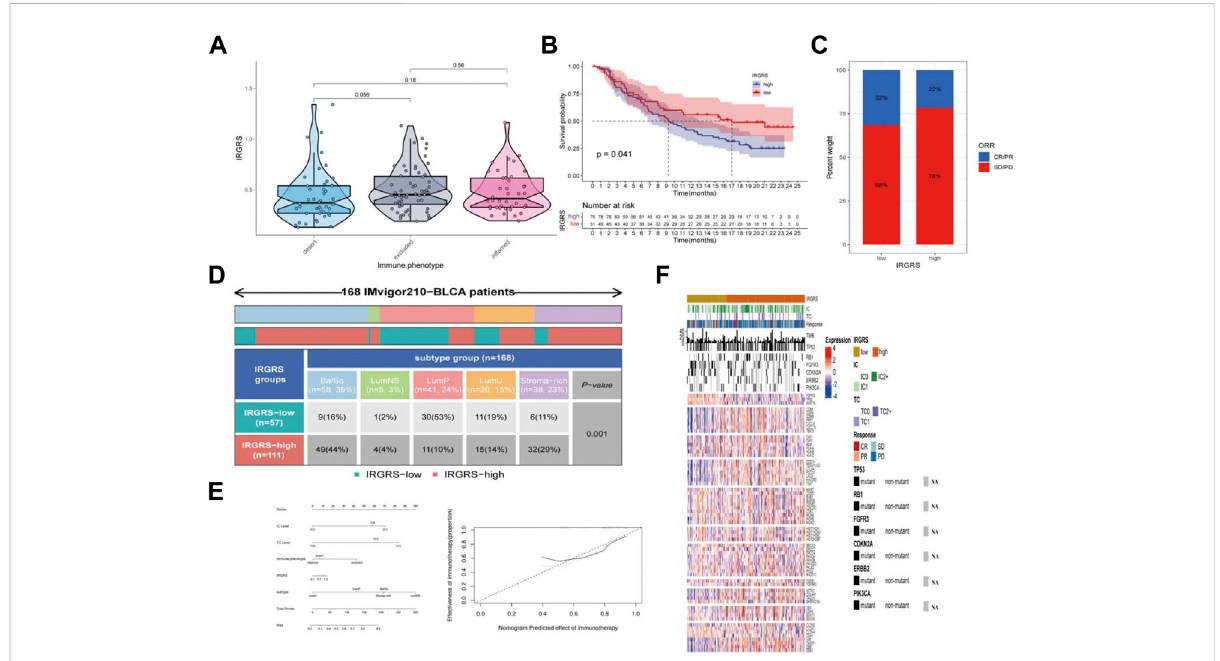
FIGURE 7 TheroleofIRGRSinpredictingtheeffectofimmunotherapyofbladdercancer. (A) .ComparisonoftheIRGRSofdifferentimmunephenotypein bladder cancer. (B) . Survival analysis of immunotherapy gene set in diferent IRGRS groups (high-IRGRS and low-IRGRS). (C) . The proportions of clinical response (CR/PR, SD/PD) after accepting immunotherapy in the high-IRGRS and low-IRGRS groups in IMgivor210 dataset (D) . Heatmap and table showing the distribution of bladder cancer consensus molecular subtypes between the IRGRS and subgroups in IMgivor210 dataset. (E) Nomogram and corresponding calibration curve for predicting survival probability in the validation cohort. (F) . Heatmap representing evaluated patients fi rst sorted based on a IRGRS-based subtyping scheme, Immune cell and tumour cell PD-L1 status are given. Then by response to atezolizumab.In addition, TMB and mutationstatus (black,mutated; grey, patients withoutmutation data) for afewgenes ofinterest are shown. The rows of the heatmap show expression (Z scores) of genes of interest, grouped into the biologies or